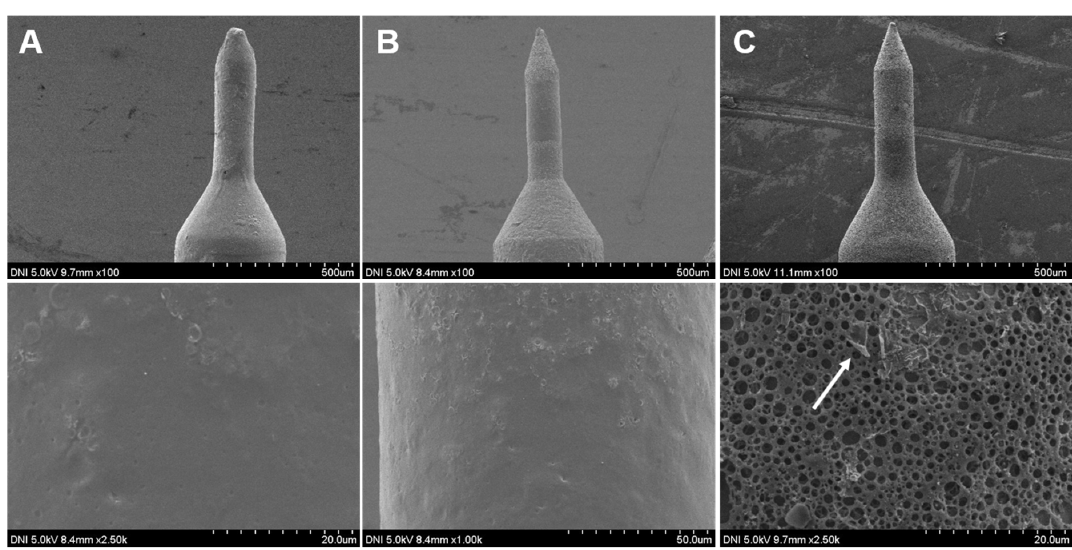
Figure 4. SEM micrographs of glucose-responsive porous coated MNs at different magnifications. ( A